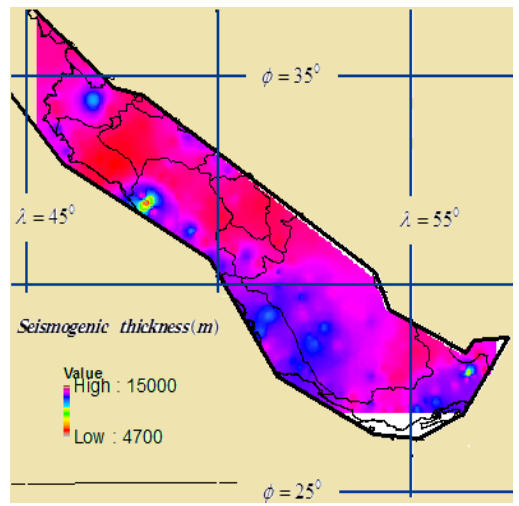
Figure 6. Changes of the seismogenic thickness in Zagros. Figure (7) and Figure (8) describe the surface deformation in Zagros. It should be noted that these parameters are defined in the geodetic coordinate system. The 2D dilative strain rate   ) shows the rate of the surface contraction or expansion in ( 2 D Zagros. The negative and the positive values mean contraction and expansion, respectively.